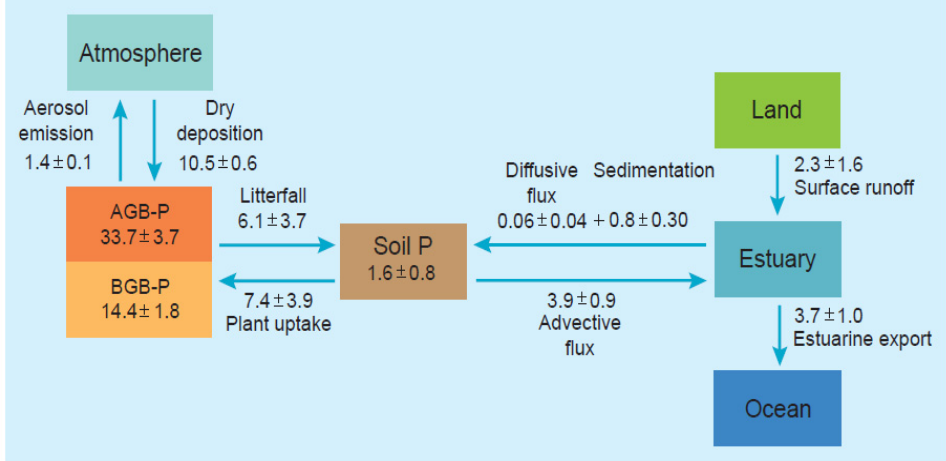
Figure 4. P budget for the Sundarbans mangrove ecosystem, India, covering an area of 4264 km 2 of mangroves and 1781 km 2 of tidal waterways. P stocks (Gg P) in aboveground (AGB-P), and belowground (BGB-P) biomass and soil P to a depth of 60 cm are presented. Fluxes are Gg P a − 1 . Source: [27]. Reproduced with permission of Springer Nature.